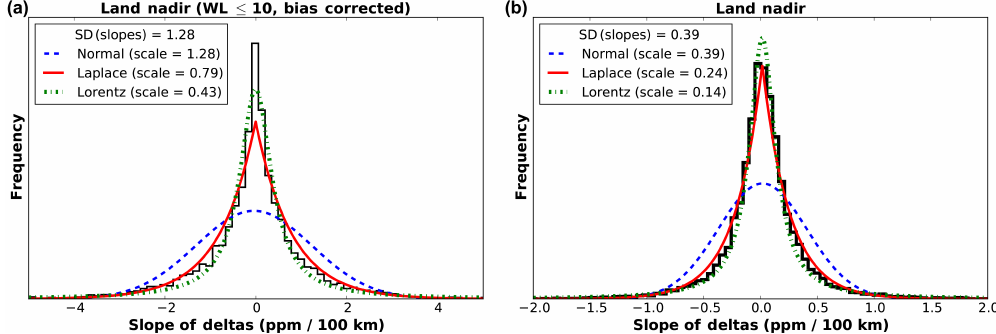
Figure 7. (a) The distributions of slopes of the observed XCO 2 gradients across all the small neighborhoods corresponding to land-nadir observations. (b) The expected distribution of slopes in XCO 2 based on the GMAO high-resolution